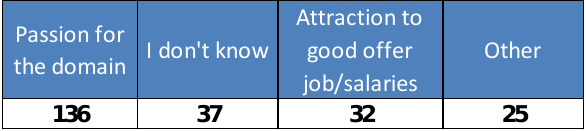
Table 1. Motivations to follow CS studies in number of answers. Answers from the students